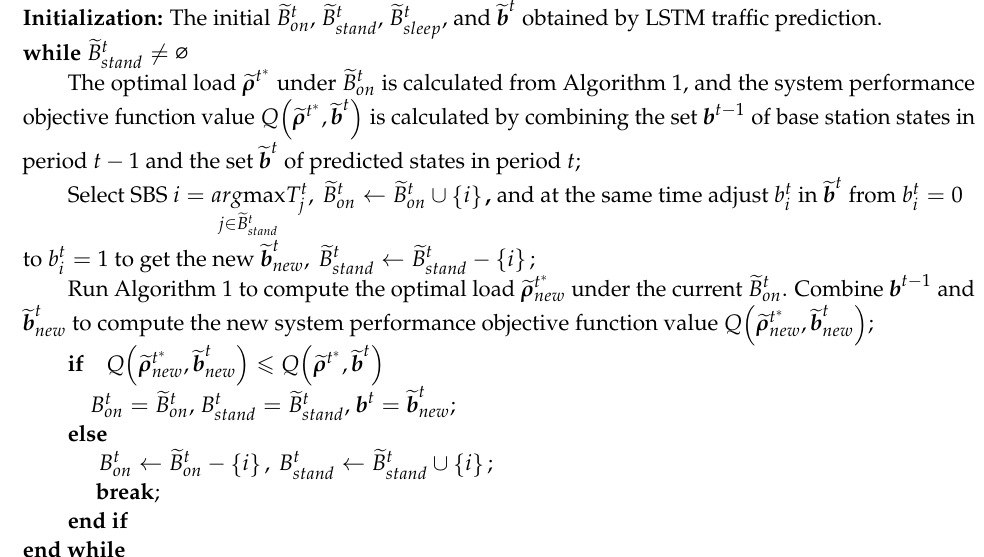
Algorithm 2. Joint optimization algorithm for SBS state control and user association